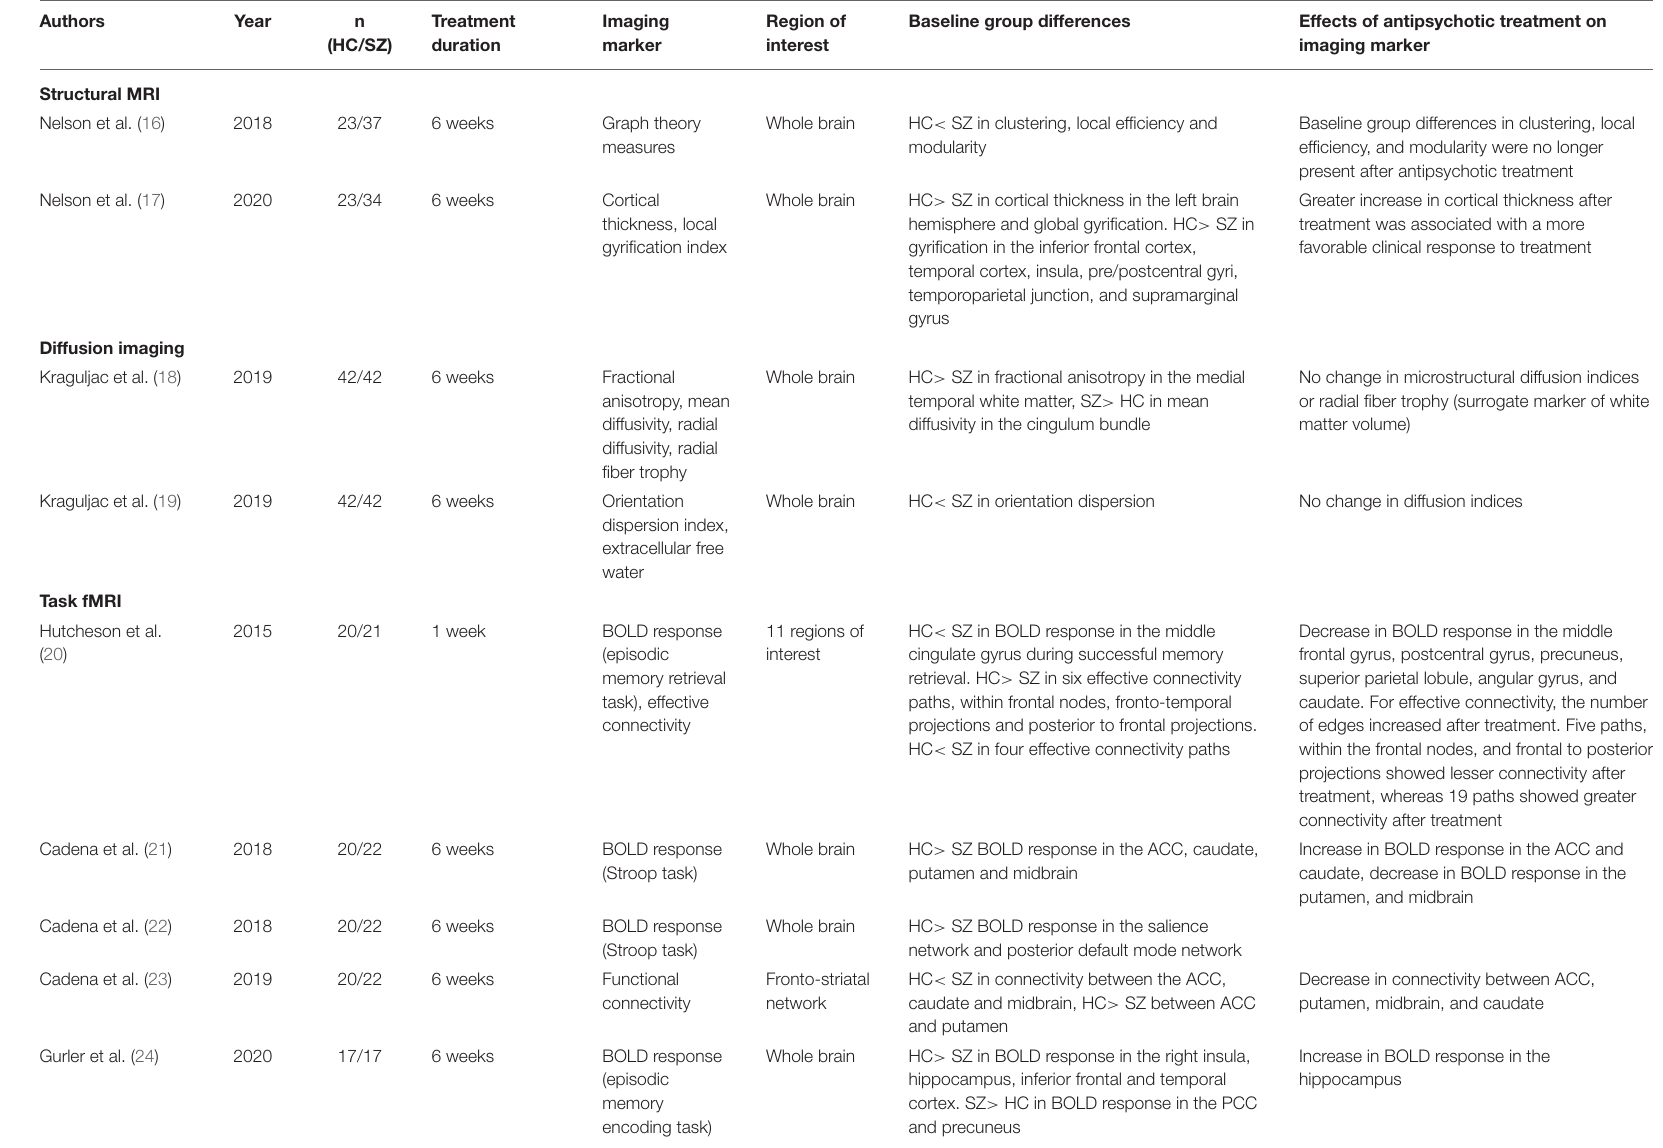
TABLE 1 | Neuroimaging studies of antipsychotic drug effects from by the authors. Authors